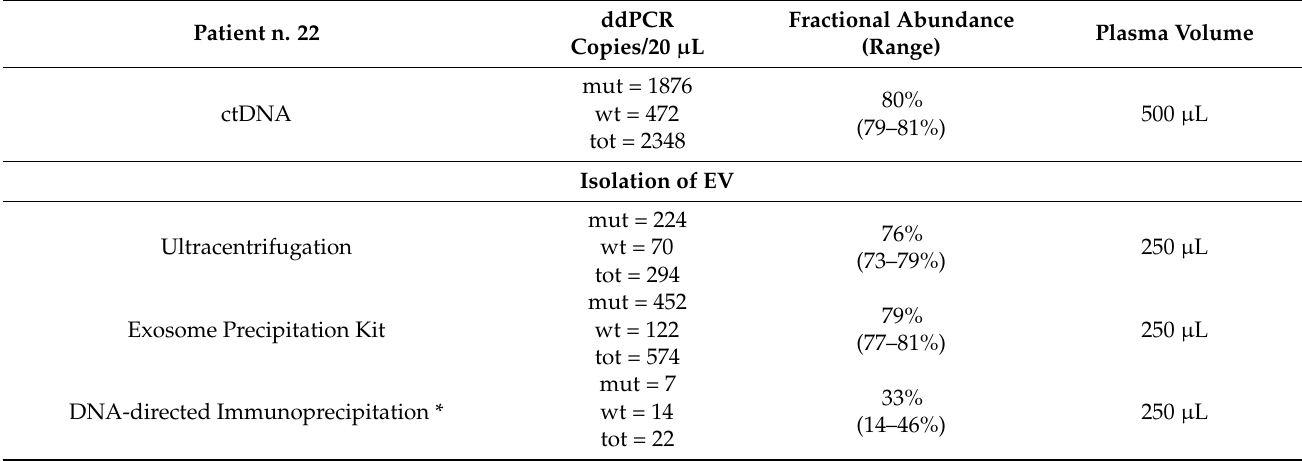
Table 2. Results obtained by ddPCR analysis for the KRAS G12D mutation on ctDNA and sEVs associated DNA. Patient n.